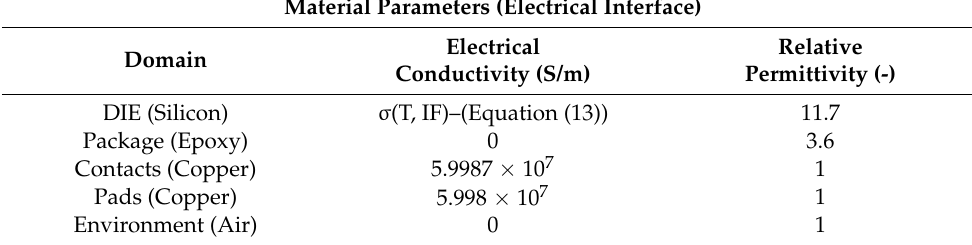
Table 2. General Material Settings (Electrical